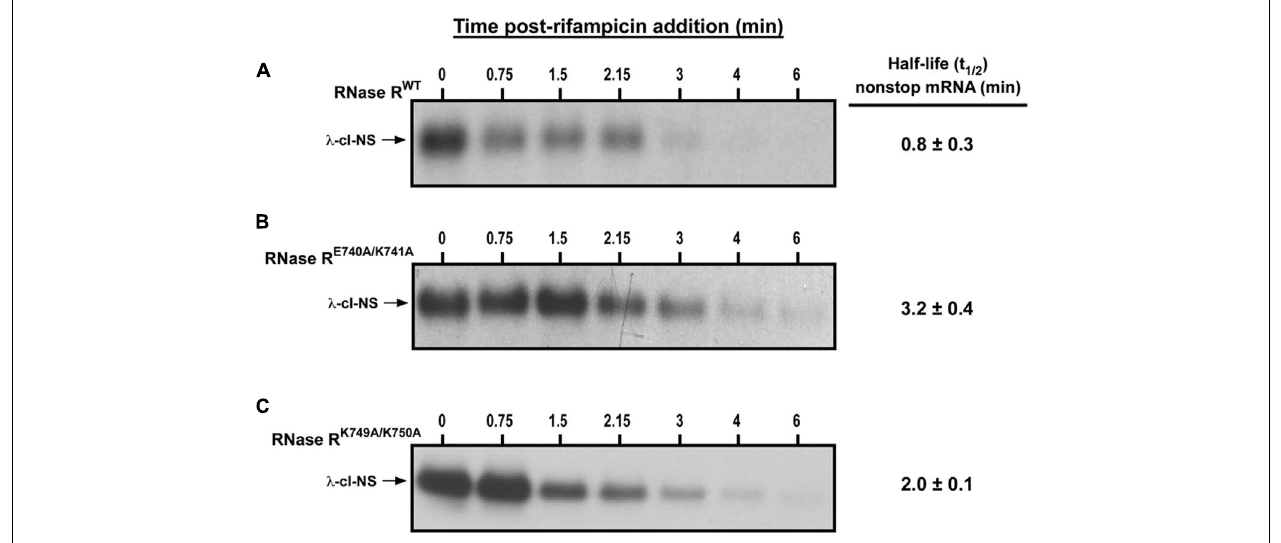
FIGURE 4 | Non-stop mRNA half-life increase in the presence of RNase R E740A/K741A and RNase R K749A/K750A . Cells co-expressing λ -cI-NS with the indicated plasmid-borne RNase R variants were harvested at the indicated time points after the addition of rifampicin. Total RNA samples isolated from equal number of cells were subjected to Northern analysis. Intensities of the bands corresponding to the λ -cI-NS reporter were quantified using ImageJ. Non-stop mRNA half-life was calculated by linear